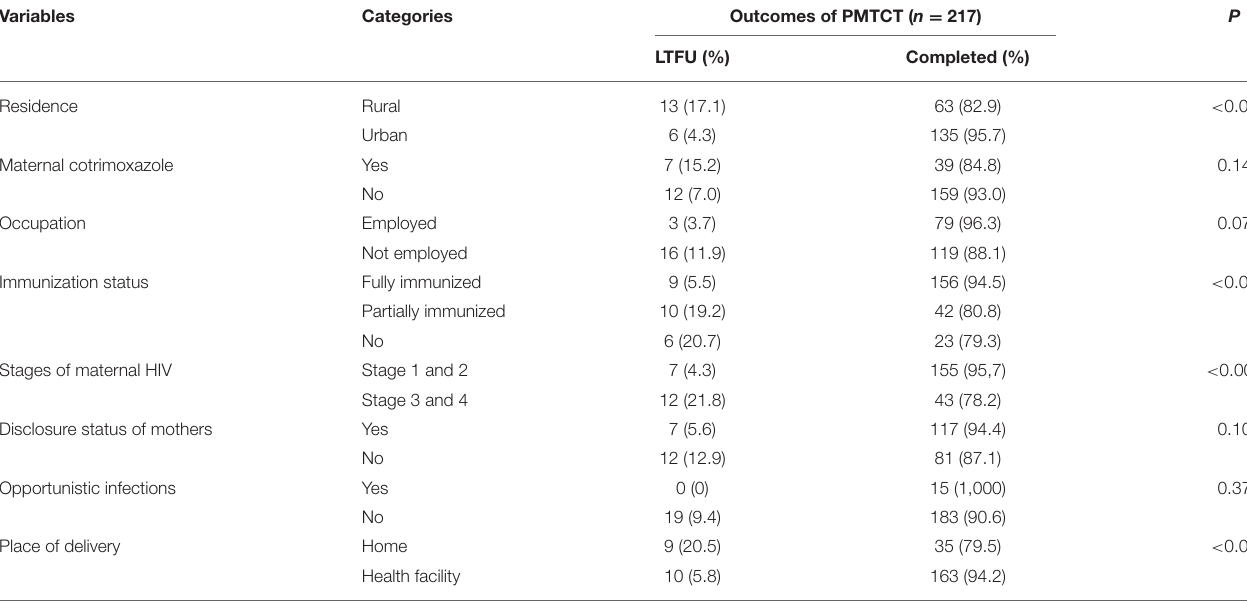
TABLE 2 | X 2 -test to assess the associations with loss to follow up among HIV exposed infants on Option B + PMTCT program in Amhara regional state referral hospitals.